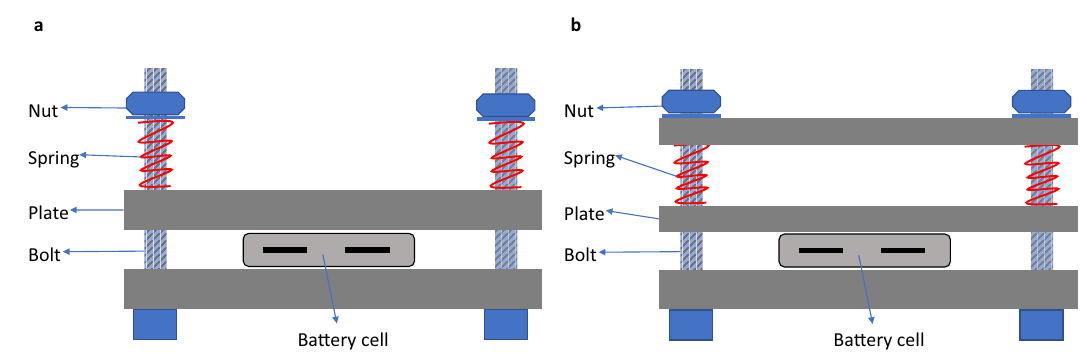
Fig. 3 Scheme illustration of common pouch format cell test fi xture designs with external pressure applied. a Two-plate design with battery cell placed in the middle between plates; b Three-plate design with battery cell placed in the middle between two bottom plates.